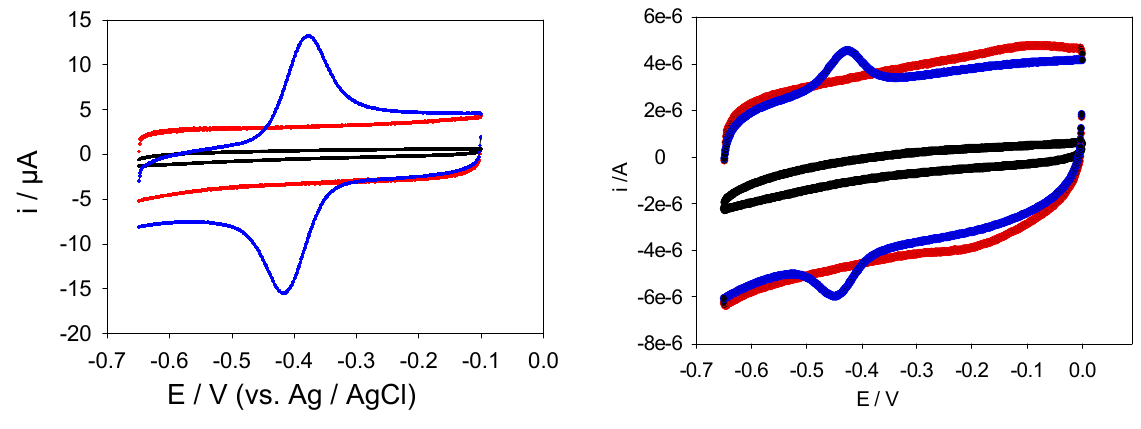
Figure 12. LHS Picture: Cyclic voltammograms recorded at a bare (black), SWCNT-modified (red) and SWCNT/GOx -modified (blue) gold working electrode. RHS Picture: Cyclic voltammograms recorded at a bare (black), SWCNT-modified (red) and SWCNT/GOx/Nafion -modified (blue) gold working electrode The electrolyte used in both sets of experiments was a 50 mM phosphate buffer (pH 7) and the scan rate employed was 100